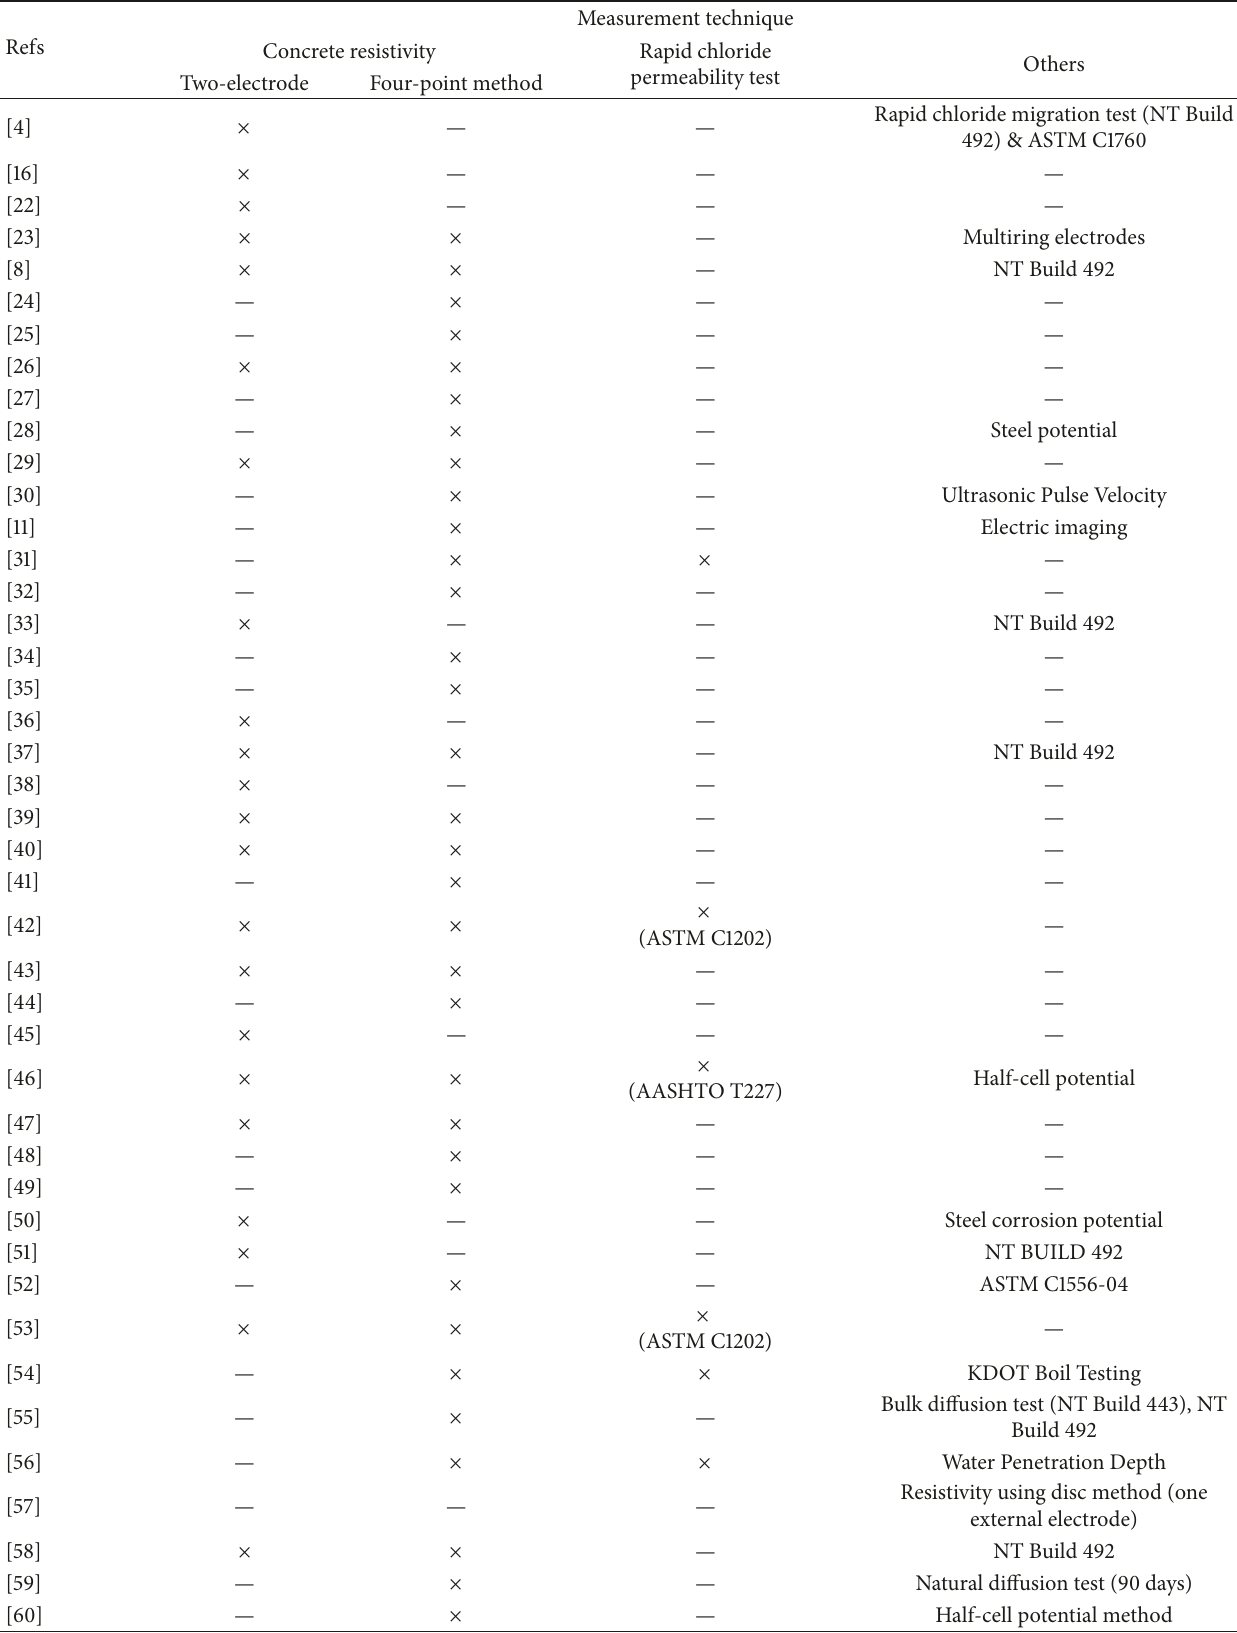
Table 4: Details of the different measurement methods used in the